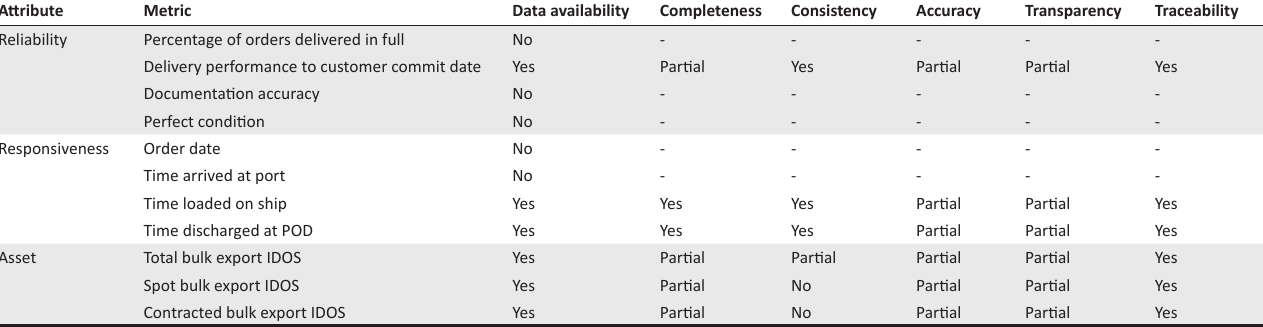
TABLE 2: Summary of the data quality for Iteration 2. Attribute